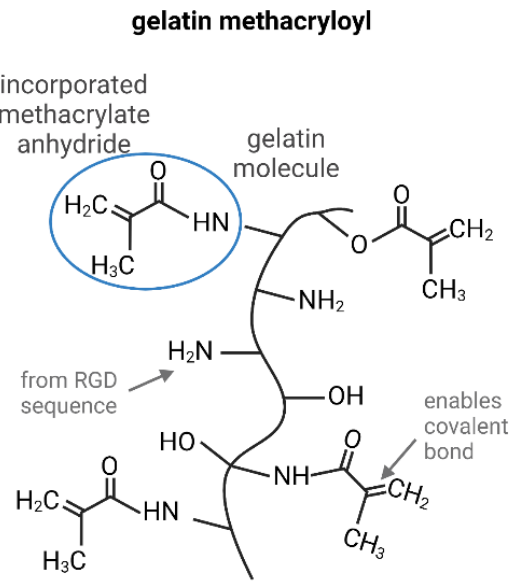
Figure 1. Productions of GelMA with modification sides, inspired by [39].